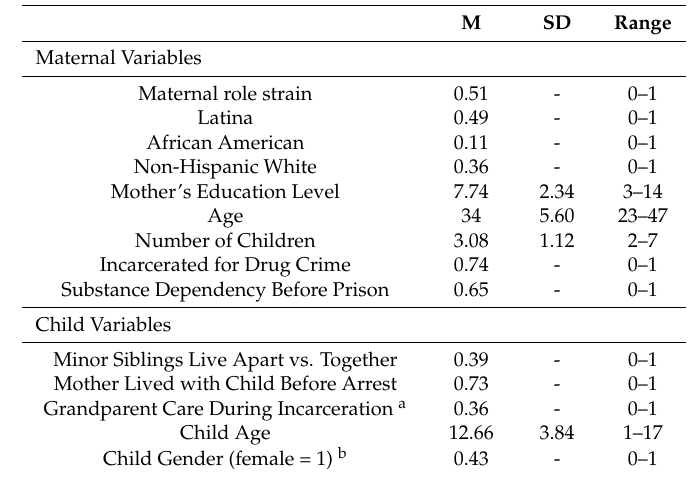
Table 1. Descriptive statistics on incarcerated mothers with multiple minor children (n = 80).